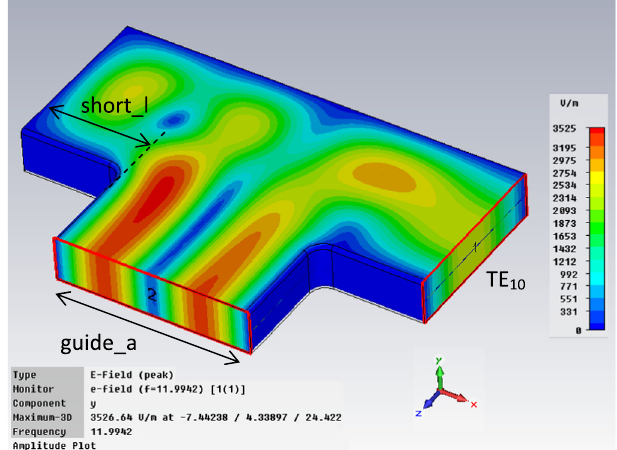
FIG. 18. Absolute E 11.9942 GHz for matching parameter L